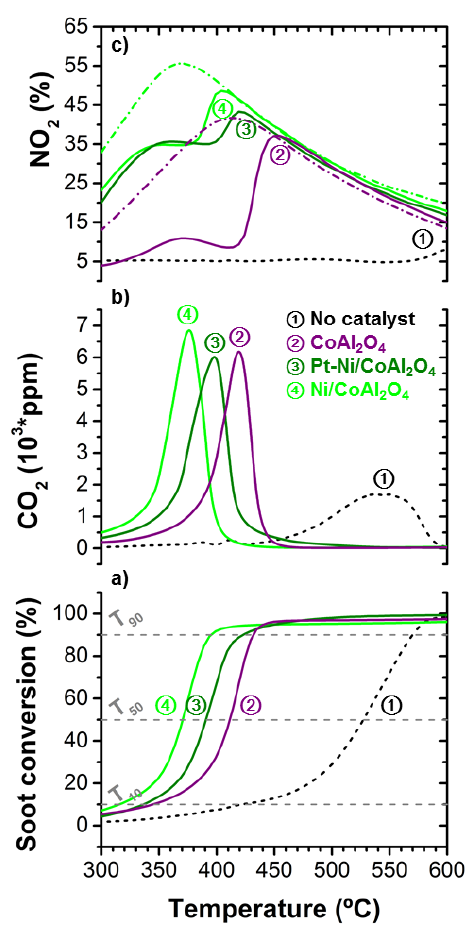
Figure 4. Catalytic oxidation tests: ( a ) Soot conversion profiles, ( b ) CO 2 concentration profiles, and ( c ) NO 2 profiles as NO 2 to NO x fraction. Reaction conditions: 100 mg catalyst + 10 mg soot, loose contact, 2500 ppm NO + 10 vol. % O 2 + N 2 , 300 mL/min, 5 °C/min. Solid lines are experiments with soot and catalyst, the dotted line is the reference experiment of non-catalyzed soot combustion, and the dotted-dashed lines in (c) are blank NO oxidation experiments with catalyst but without soot. Table 1. Comparison of diesel soot combustion catalysts tested in laboratory conditions (“loose” soot-catalyst contact and NO x + O 2 mixture).